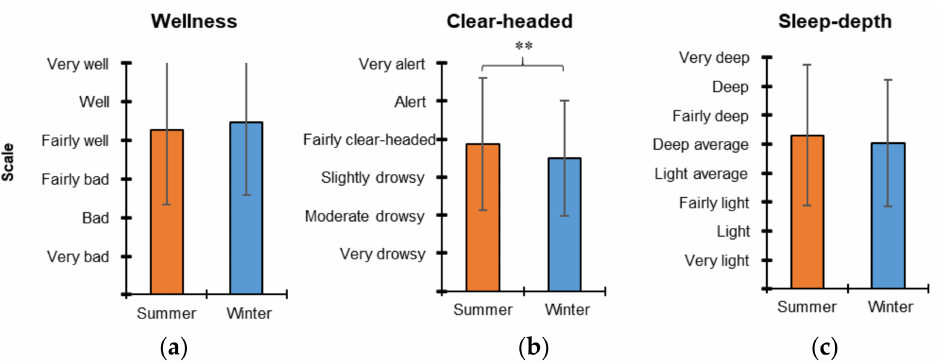
Figure 6. Sleep experience based on SMH questionnaire: ( a ) wellness, ( b ) clearheadedness, and ( c ) sleep-depth; Significancy: ** p < 0.05.